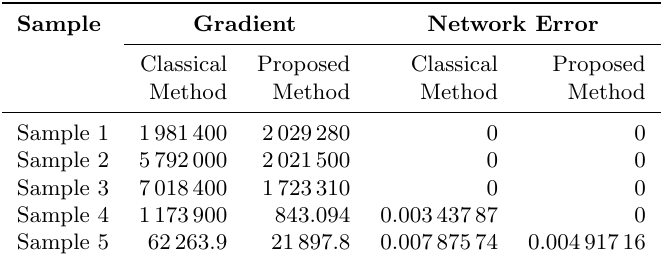
Table 3: Comparison of gradient values and errors in the network for five samples.